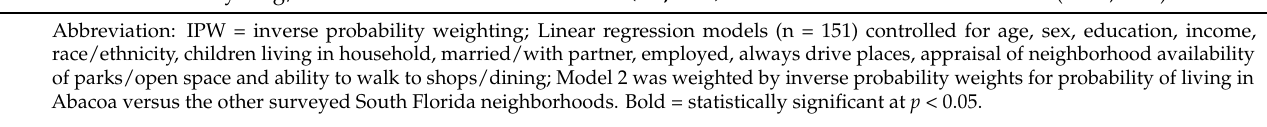
Table 5. Association between living in Abacoa neighborhood and minutes walking and bicycling per week, using and not using inverse probability weights to account for neighborhood self-selection. Model 1—with no IPW Model 2—with IPW Outcome Minutes of neighborhood